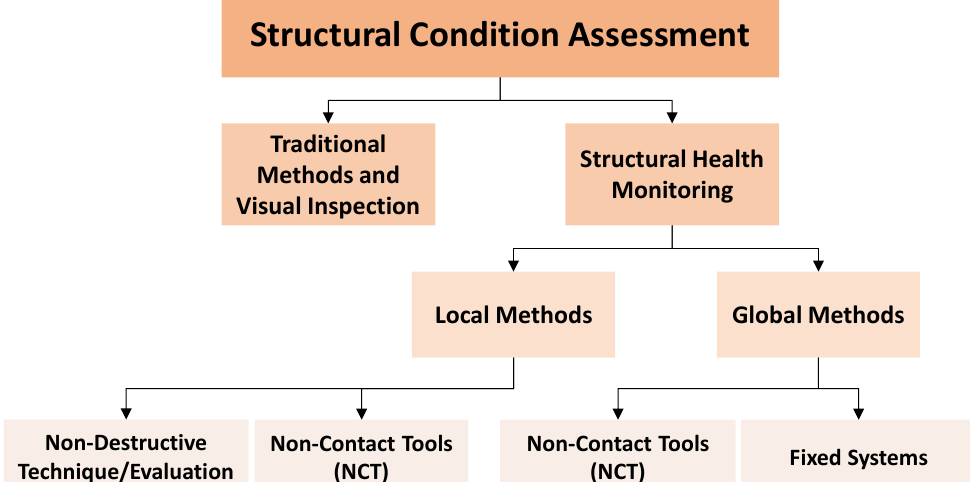
Figure 1. Structural condition assessment methods: traditional methods and visual inspection and structural health monitoring by their application levels.